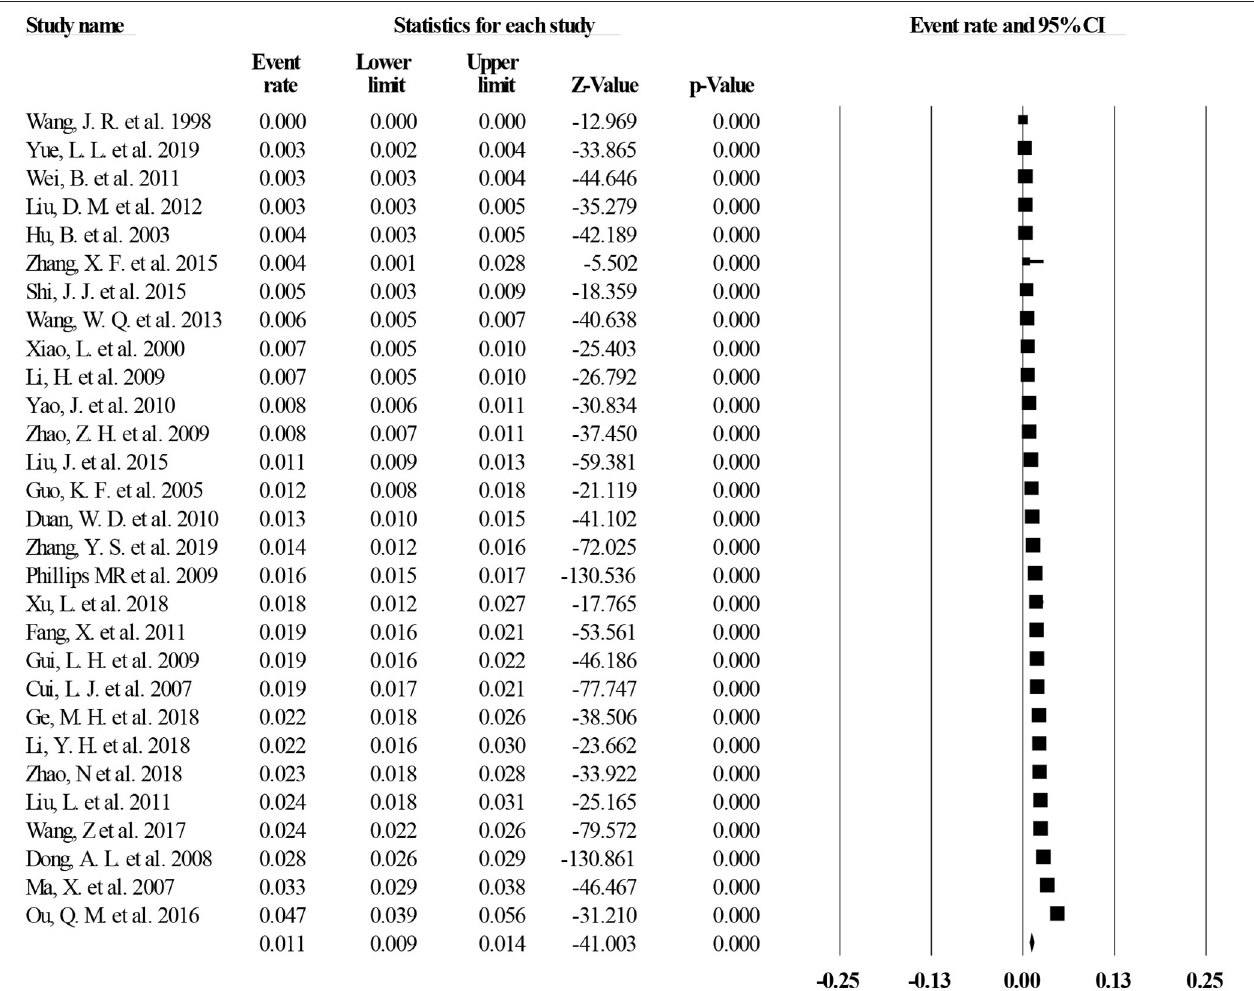
FIGURE 4 | Point prevalence of MDD in